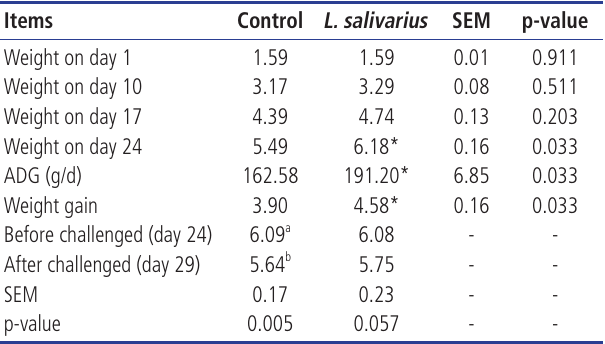
Table 2. Effect of Lactobacillus salivarius on pig weight (kg) of piglets before and after being challenged with Escherichia coli F4 Items